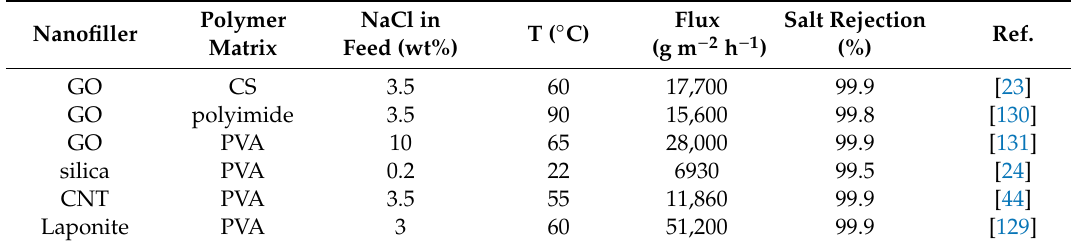
Table 3. Nanofillers used in PV